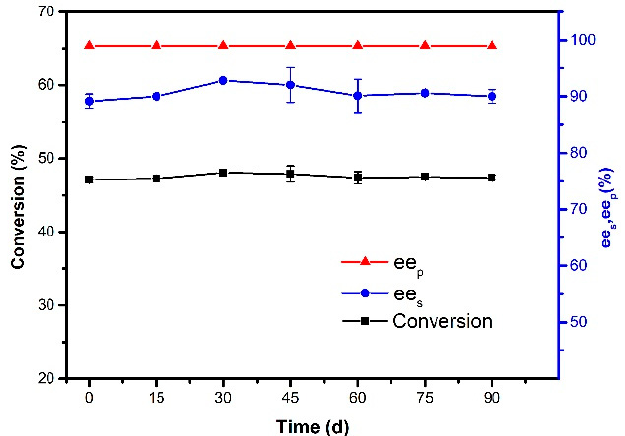
Figure 13. The storage stability of magnetic CALB CLEAs. Reactions performed with 5 mg magnetic CALB CLEAs and 2 mL of n -hexane containing 0.2 mmol of 1-phenylethanol and 0.4 mmol of vinyl acetate at 50 °C for 48 h.